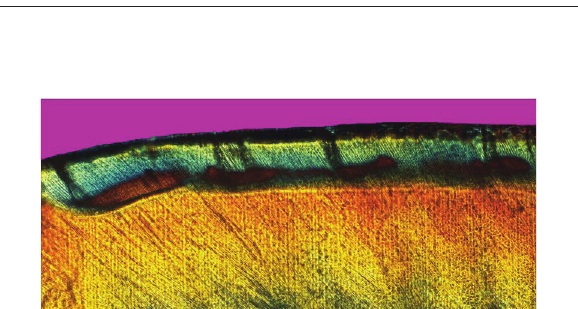
Figure 3: SEM image at 75x. The lesion appears as a well-defined area with distinct borders both in depth and width. Here is the lesion of lighter colour and having less structure compared to the sound